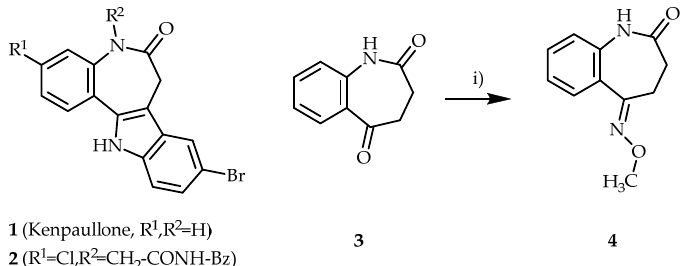
Scheme 1. Left: Structures of kenpaullone ( 1 ) and the antitrypanosomal paullone 2 . Right: Synthesis of ( E )-5-(methoxyimino)-1,3,4,5-tetrahydro-2 H -benzo[ b ]azepin-2-one ( 4 ). Reagents, conditions and yields: i) pyridine, O -methylhydroxylamine, ethanol, reflux, 4–7 h, 73–74%.